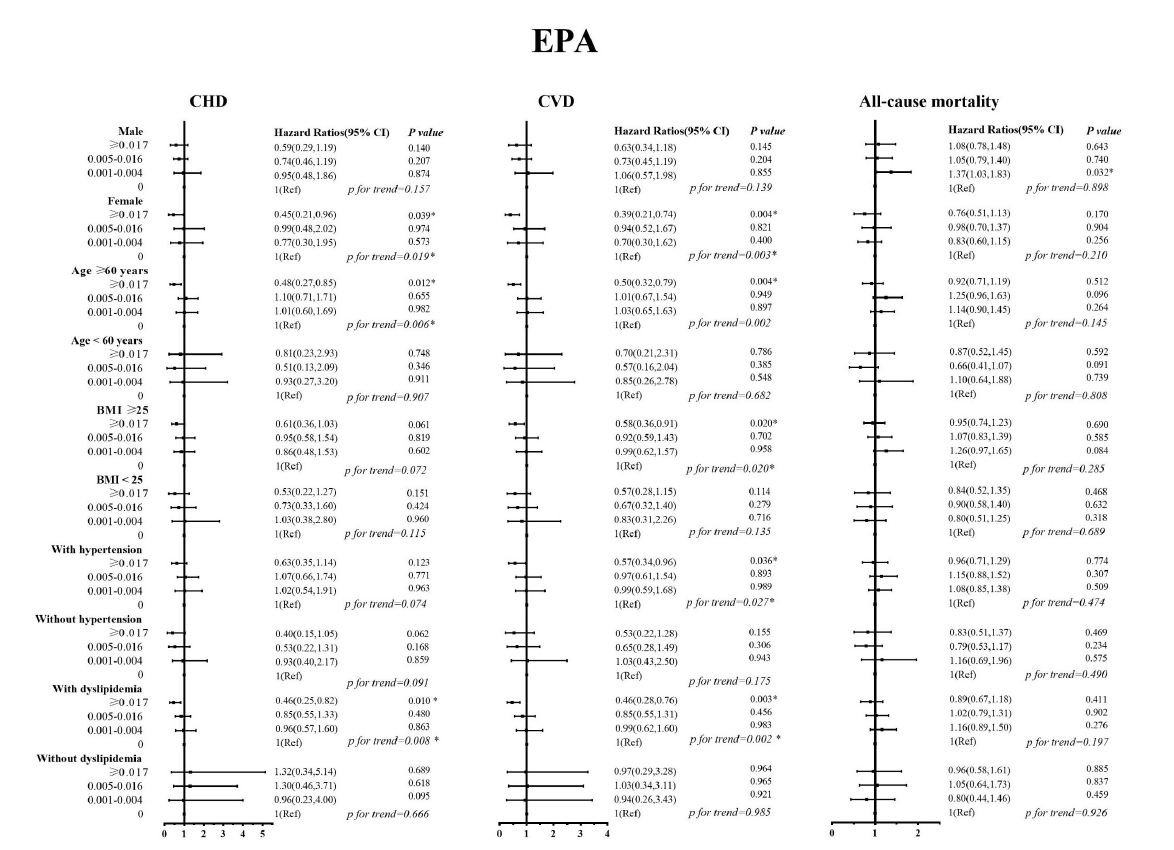
FIGURE2 Stratified analyses by sex, age, body mass index, history of hypertension, and history of dyslipidemia for the associations between EPA and the mortality from cardiovascular disease, coronary heart disease, and